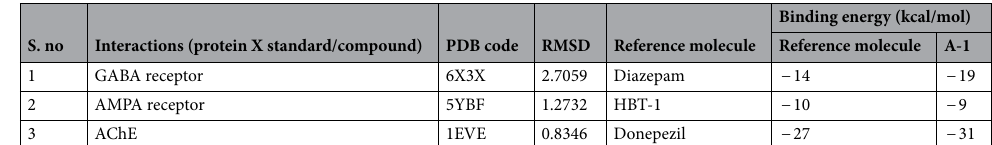
Table 1. Binding energies. GABA Gamma-aminobutyric acid, Glu AMPA α-Amino-3-hydroxy-5-methyl-4- isoxazolepropionic acid, AChE Acetylcholinesterase, kcal/mol Kilocalories per mole.